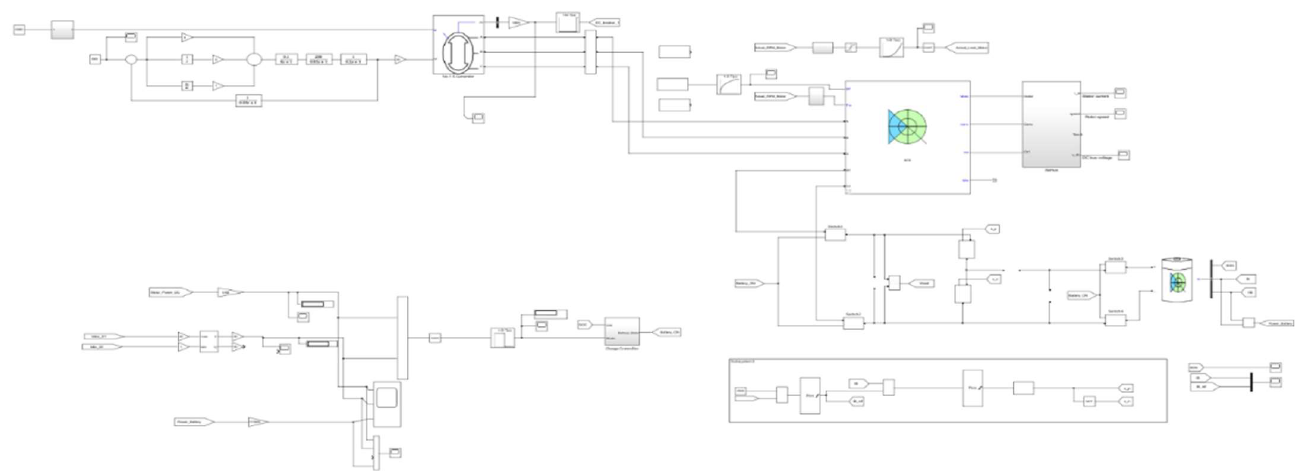
Figure 5. Matlab modeling of a battery hybrid system.